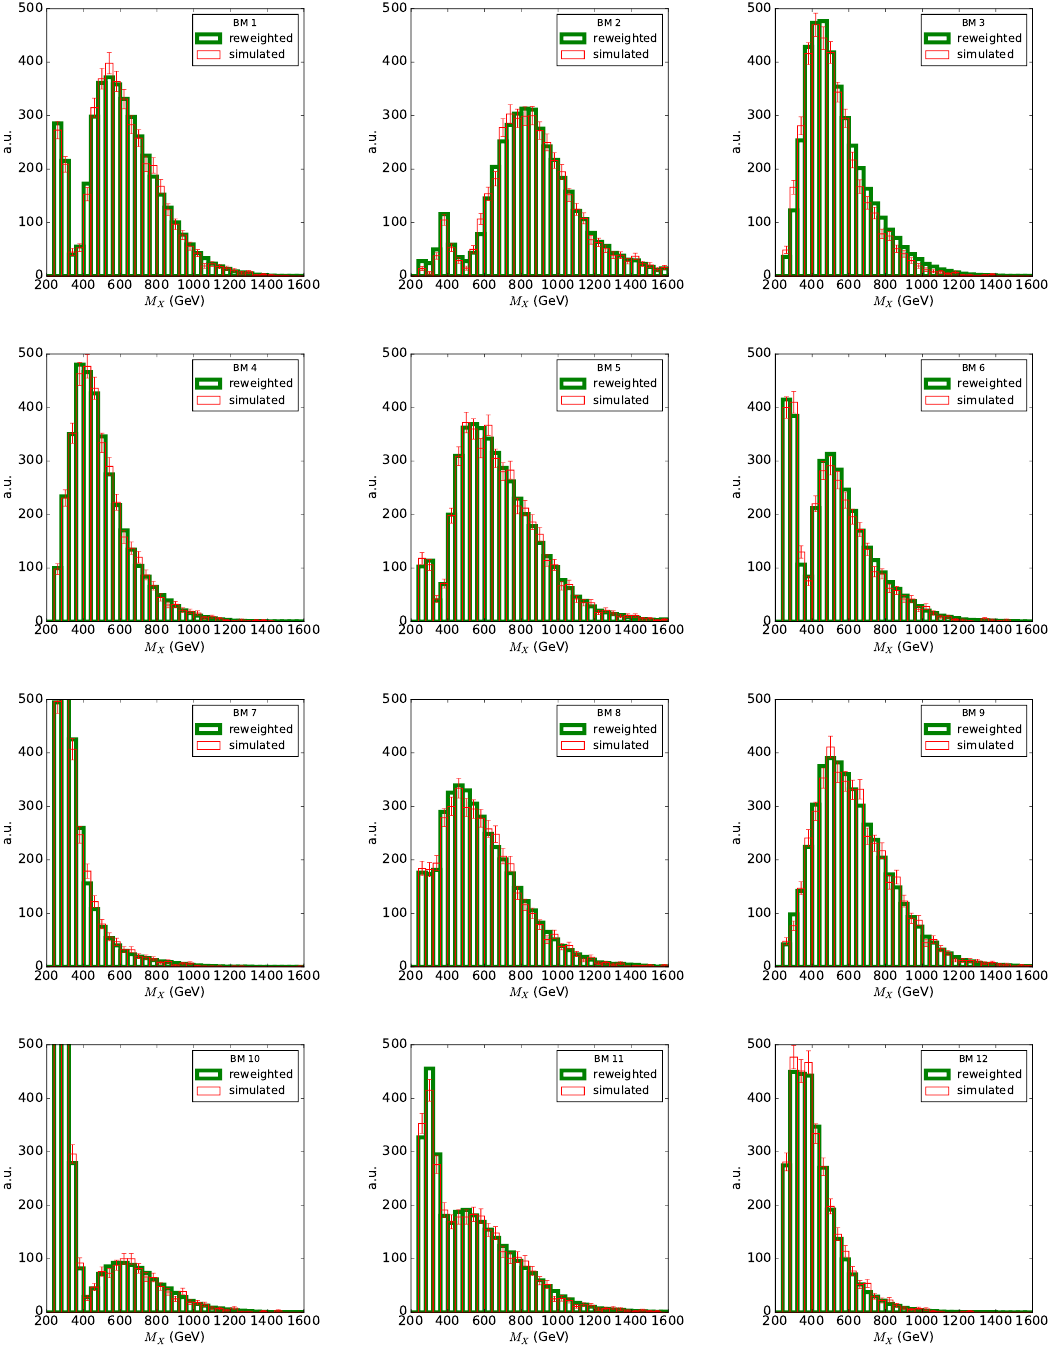
Figure 15 . The reconstructed reduced mass after ATLAS-like selection. The histograms are normalized by signal efficiency times 100,000